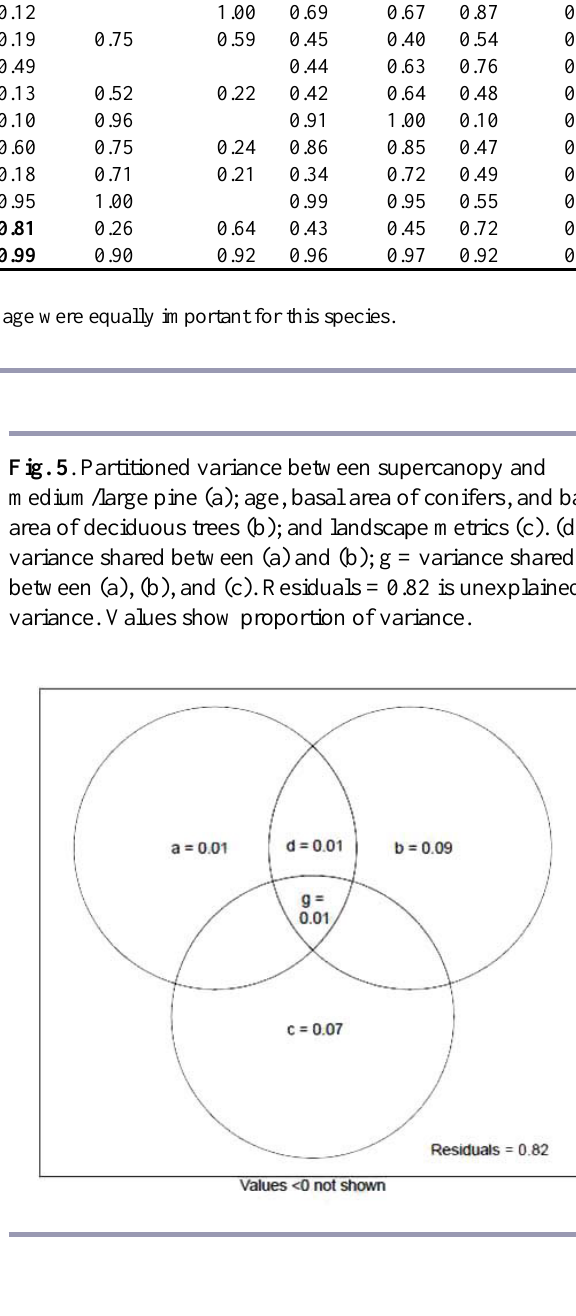
Medium/large Conifer pine pine